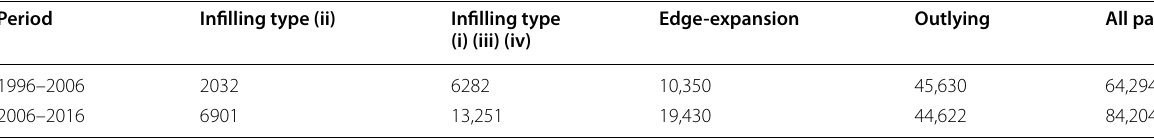
Table 7 Number of the built-up patches in each pattern Period